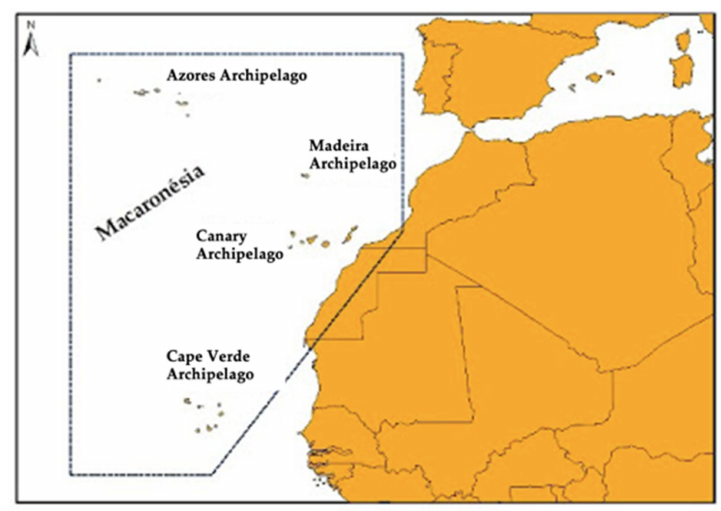
Figure 4. Macaronesia Region location map (adapted from